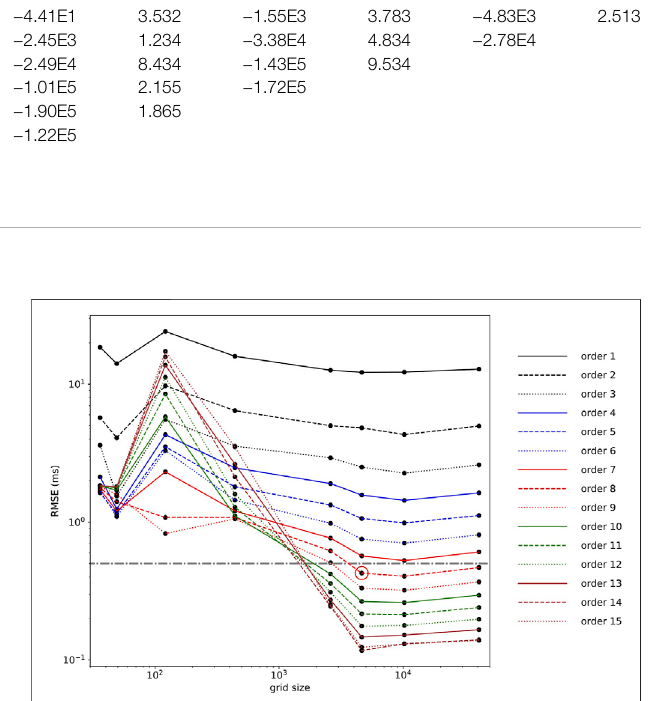
FIGURE 5 | Differences between t g values ( Δ t g ) computed numerically (Section 2) and using the eighth-order polynomial model for the testing set (15% points). A difference larger than 2 ms was depicted for only two points (green and yellow circles) in the testing set, which were close to the boundary limit.